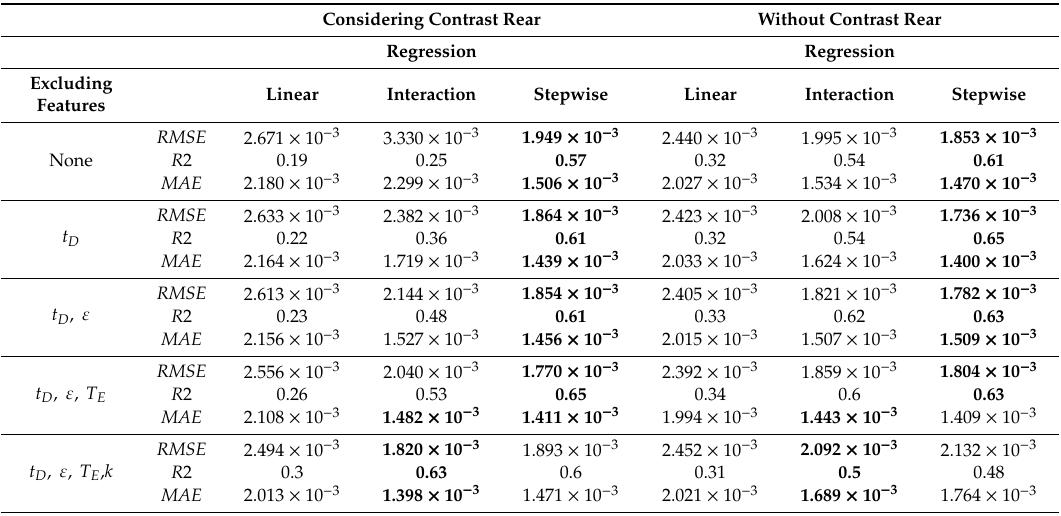
Table 3. Performance results for defect length predictor models using a dataset of 100 sets of values. The models with the best predictive performance are indicated in bold